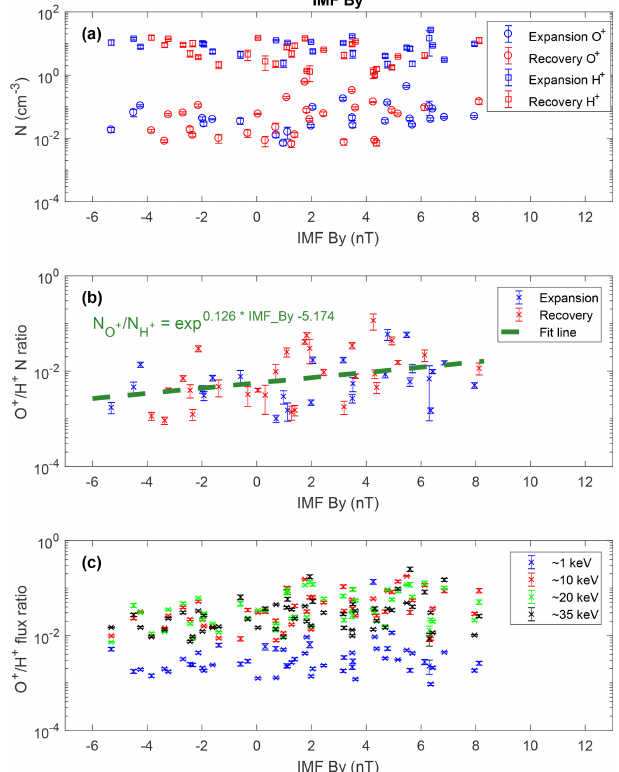
Figure 4. The relationship between the energetic O + at the duskside magnetopause and the AE index during intense substorms. From top to bottom, panels show the O + and H + densities (a) , the O + / H + density ratio (b) , and the O + / H + particle flux ratio (c) , respectively. Error bars indicate 90% confidence intervals.